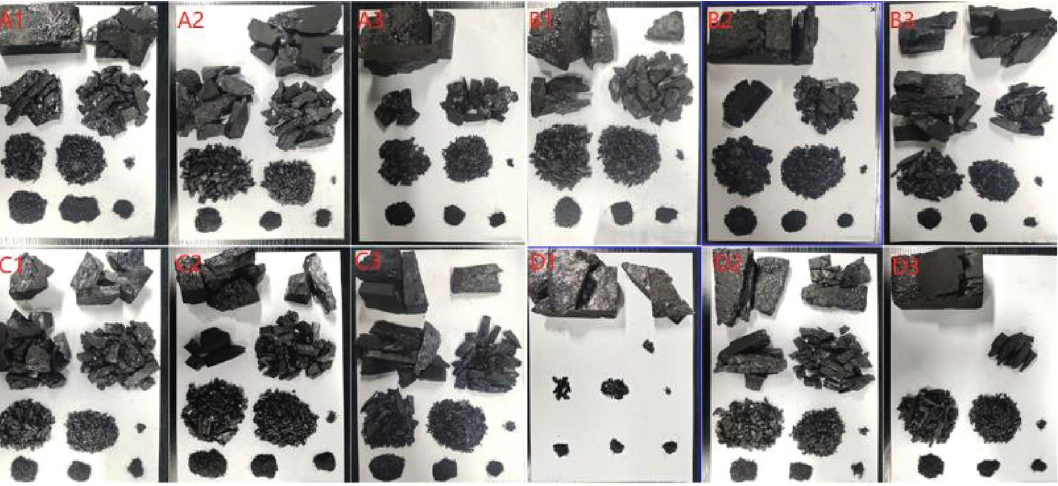
Figure 16: Initial screening and classi fi cation of specimen fragments.